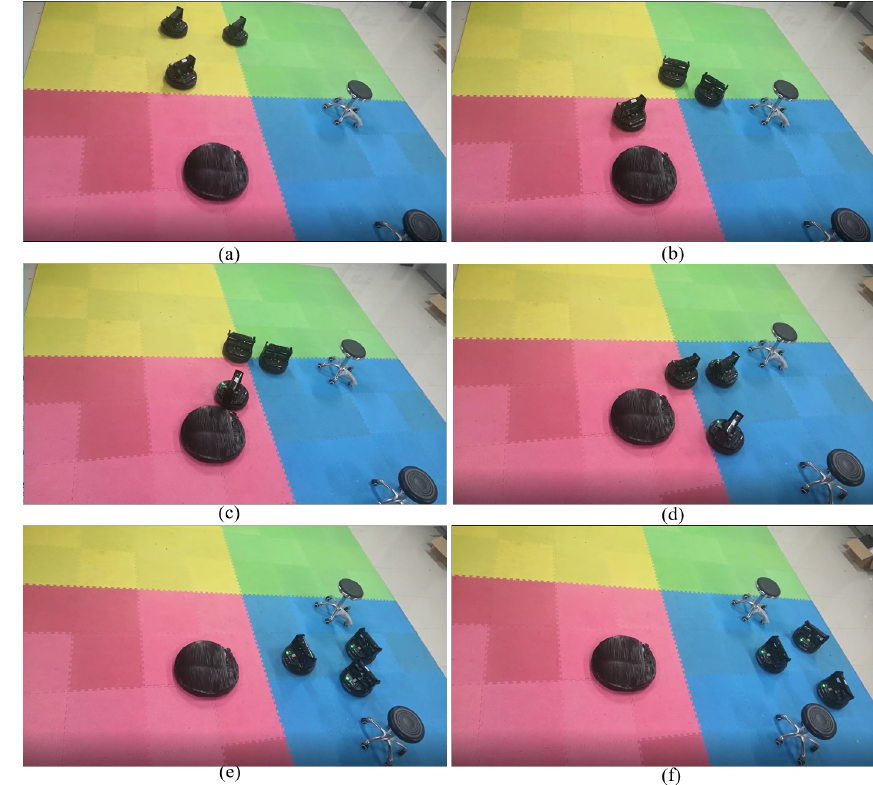
Figure 18. The experimental performance under C1–P2. ( a – f ) represent the performance every 15 s.